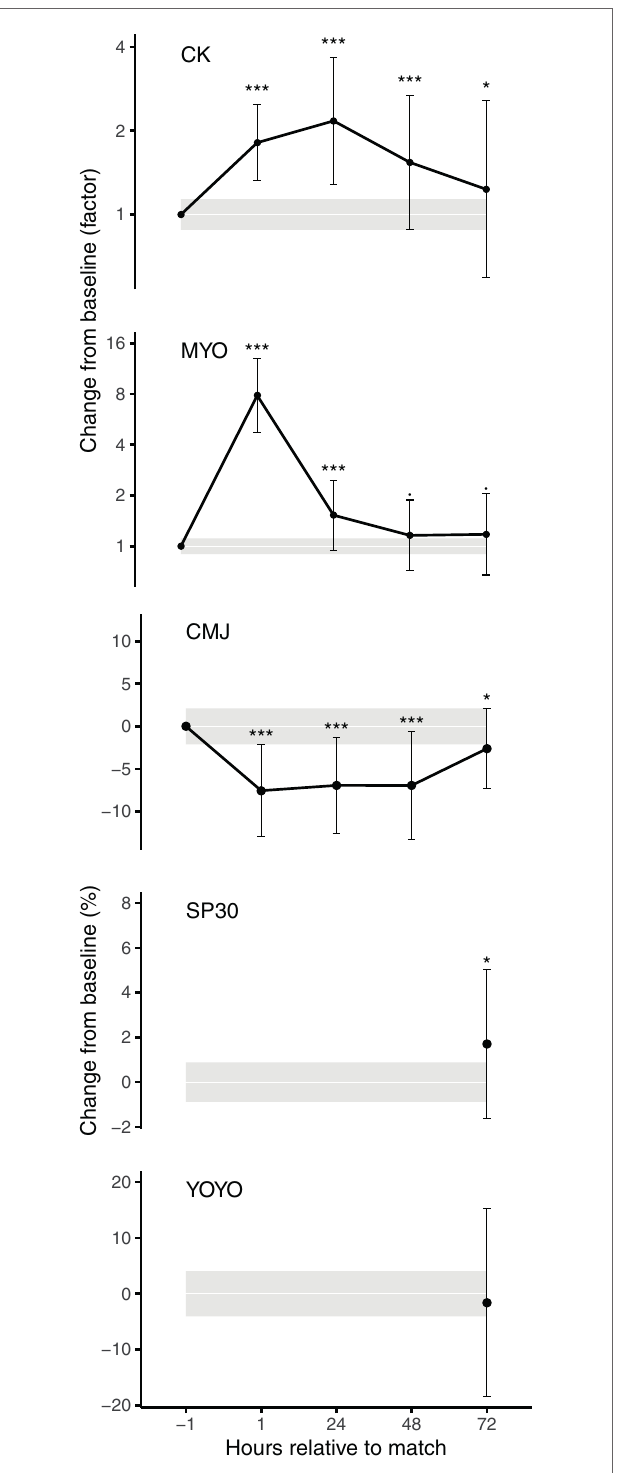
FIGURE 2 | Factor or percent change from baseline for the specific recovery markers in the hours post-match, adjusted for baseline, PlayerLoad TM , and YOYOmax. The spread is indicated by SD and shaded area represents trivial changes. Probabilistic statements about the true effect are labeled as follows: · = possibly, * = likely, and *** = most